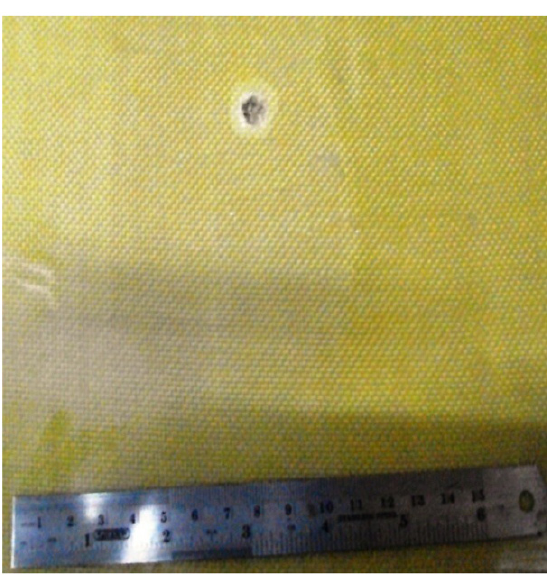
Figure 3. Damage area at front face of 0/90.